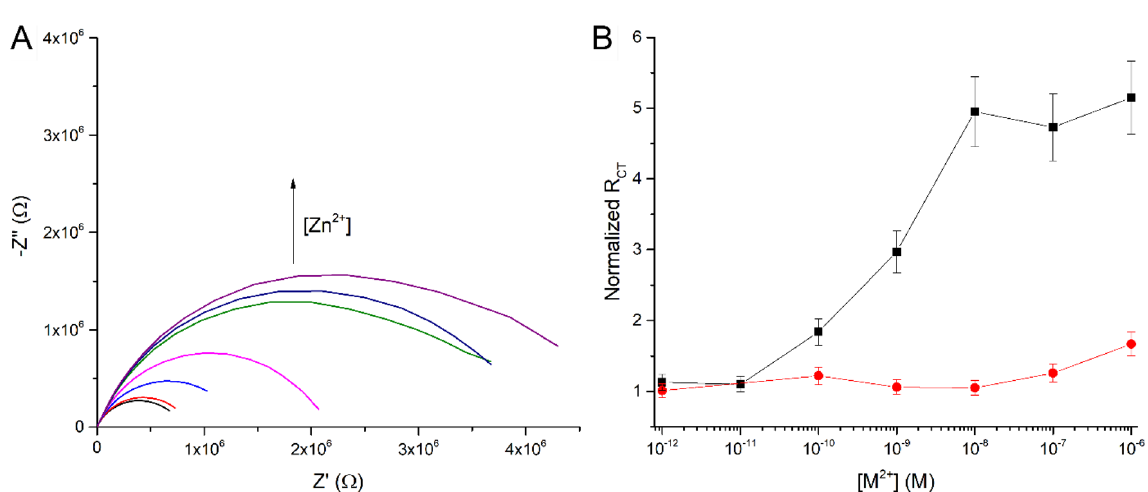
Figure 4. Nyquist plots for ( A ) different Zn 2+ ion concentrations and ( B ) dose–response of Dd-OT sensor to Zn 2+ (black curve) and Cu 2+ (red curve) ions. The presented averaged values are based on measurements from three different electrodes (Figure